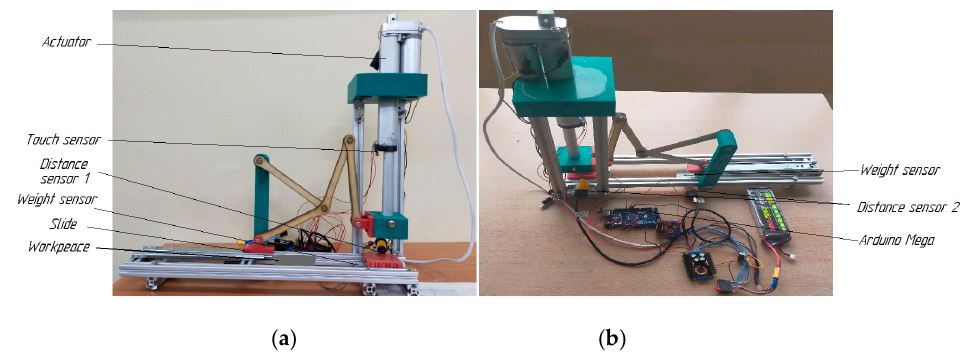
Figure 8. Graphics of the parameters s P A prototype of the PM with two sliders, and a block scheme of its characteristics are shown in Figures 9 and 10, respectively.